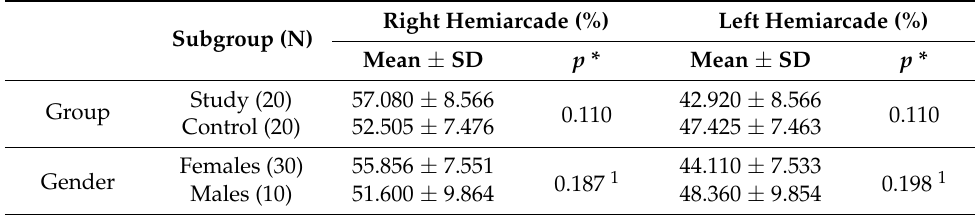
Table 3. Distribution of occlusal forces on the hemiarches in the MI position. Right Hemiarcade (%) Left Hemiarcade (%) Subgroup (N) Mean ± SD